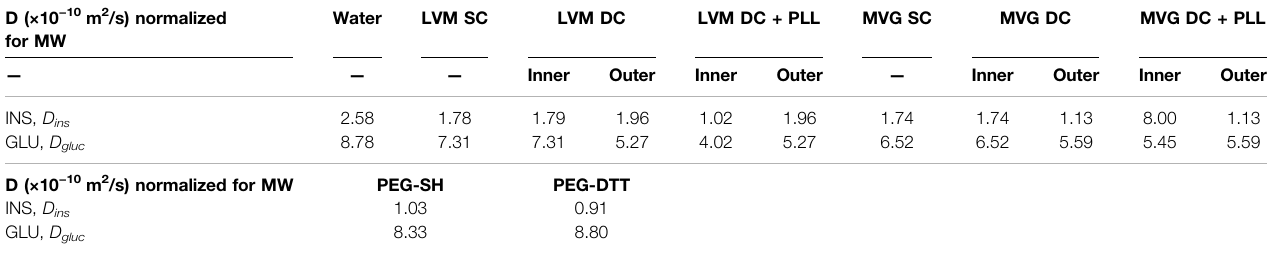
D (×10 − 10 m 2 /s) normalized for MW